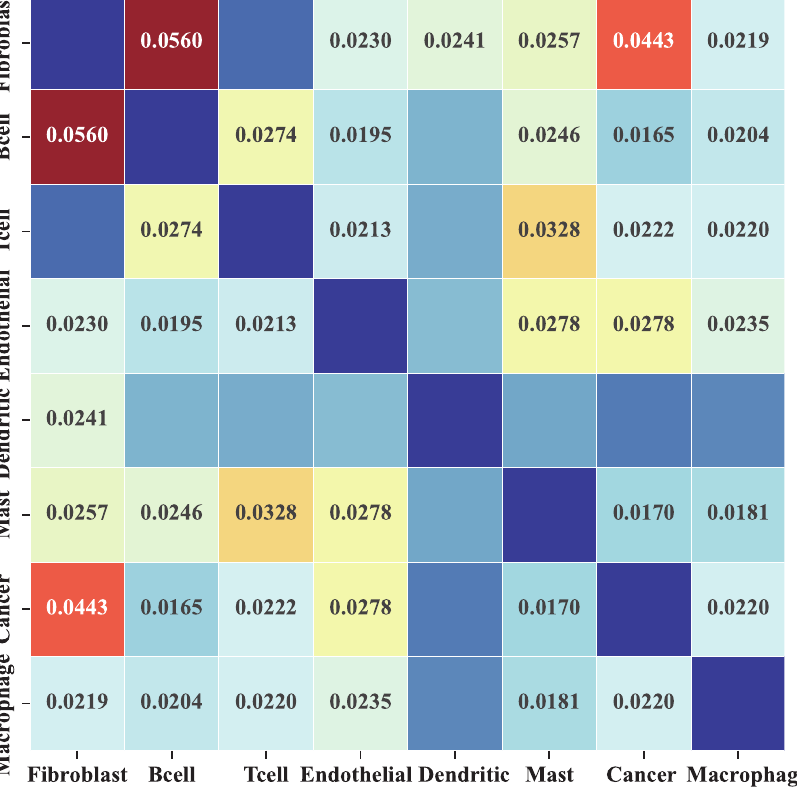
Figure 3. The Pearson correlation of different cell-type GRNs. Each element in the matrix represents the Pearson correlation of the GRN corresponding to two different cells. We do not show the results with a p -value greater than